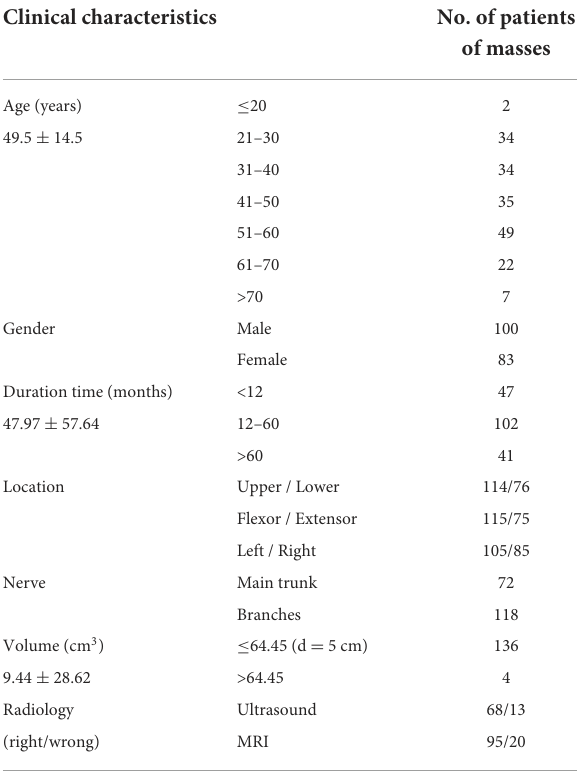
TABLE 1 Summary of clinical characteristics of patients and masses. Clinical